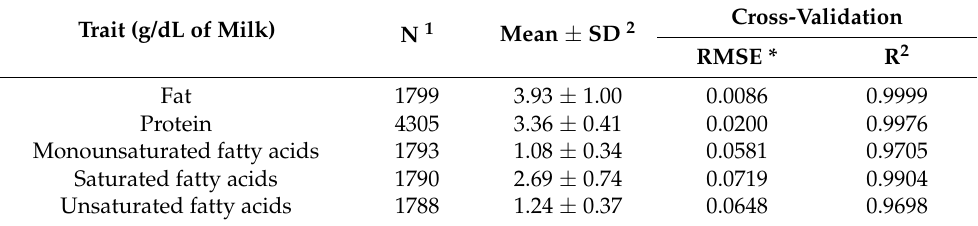
Table 1. Prediction performances of the external equations used to predict the contents of five milk